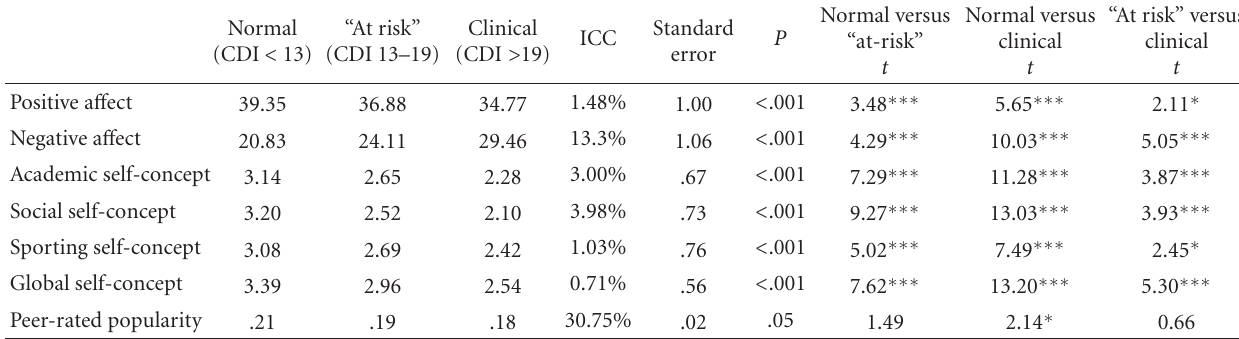
Table 3: Main e ff ect of depressive symptom level on a ff ect, self-concept, and peer-rated popularity.